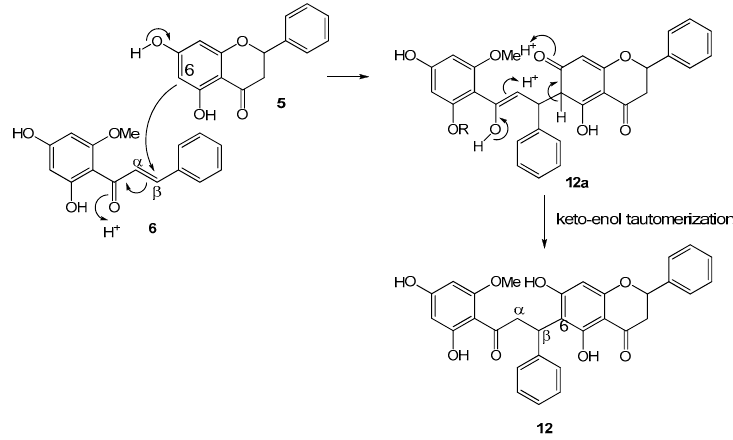
Figure 3. Proposed biogenetic pathway for flavanone - coupled chalcones 9 , 12 , and 13 .